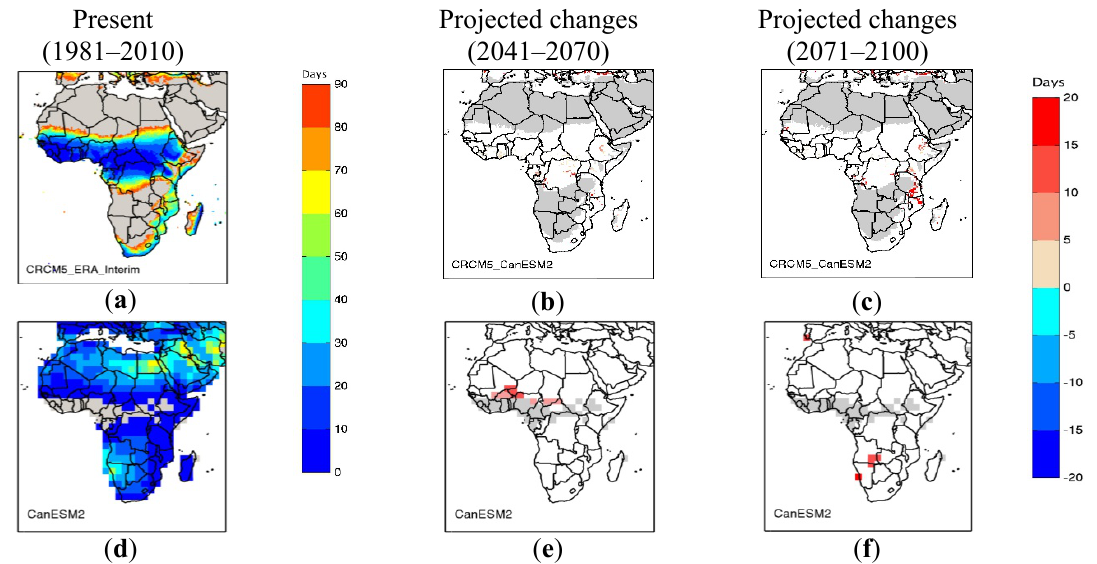
Figure 13. Same as Figure 6, but for the 5-year return level of the boreal summer maximum dry spell duration. The grid points where the return levels are larger than 93 days or where return levels were not computed due to insufficient values of maximum dry spell duration are masked in grey color.